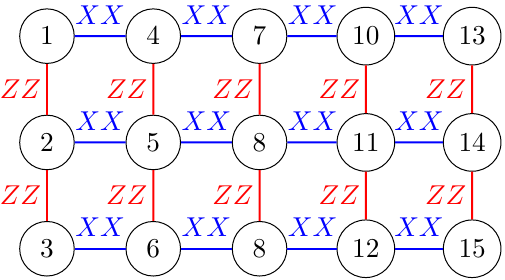
Figure 4. The 15 qubit 3 × 5 Bacon-Shor code and its gauge